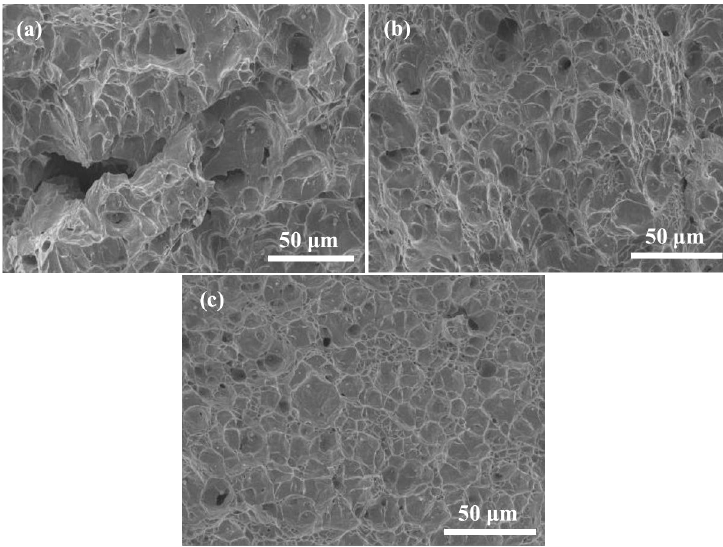
Figure 9. Impact fracture morphologies of the 0#–2# experimental specimens: ( a ) 0#; ( b ) 1#; ( c ) 2#.